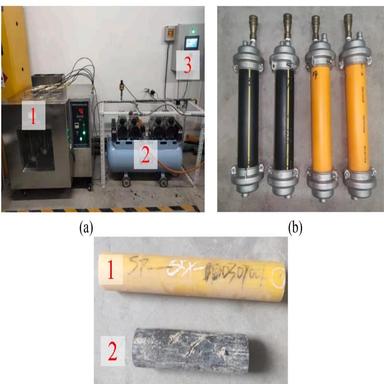
(a) Structure of the aging device consist of ①heating oven, ②air compressor, ③programmable controller, (b) PE80 and PE100 pipe samples with end caps, (c) two categories of PE pipes with service life of ① 15 years and ② 25 years.